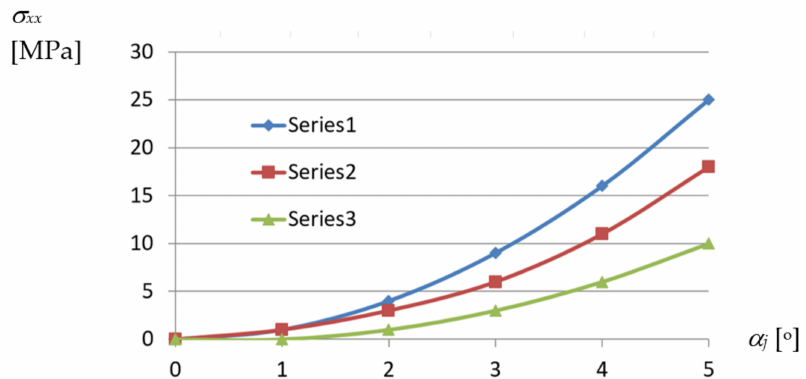
Figure 22. Relations between σ xx normal stresses acting along longitudinal axes and α j unit angle of numerically transformed sheets of the following profiles: Series1—TR50 × 0.75 mm × 6.2 m; Series2—TR60 × 0.75 mm × 6.2 m; Series3—TR130 × 0.75 mm × 6.2